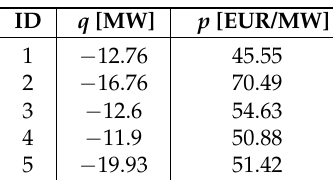
Table A6. Reference (non-SRDB) RD+ bid set: The columns correspond to the index of the bid (ID), quantity ( q ) and bid price ( p ) respectively. The SRDB bids are generated according to u , and the implied actual set of uncertain energy bids.